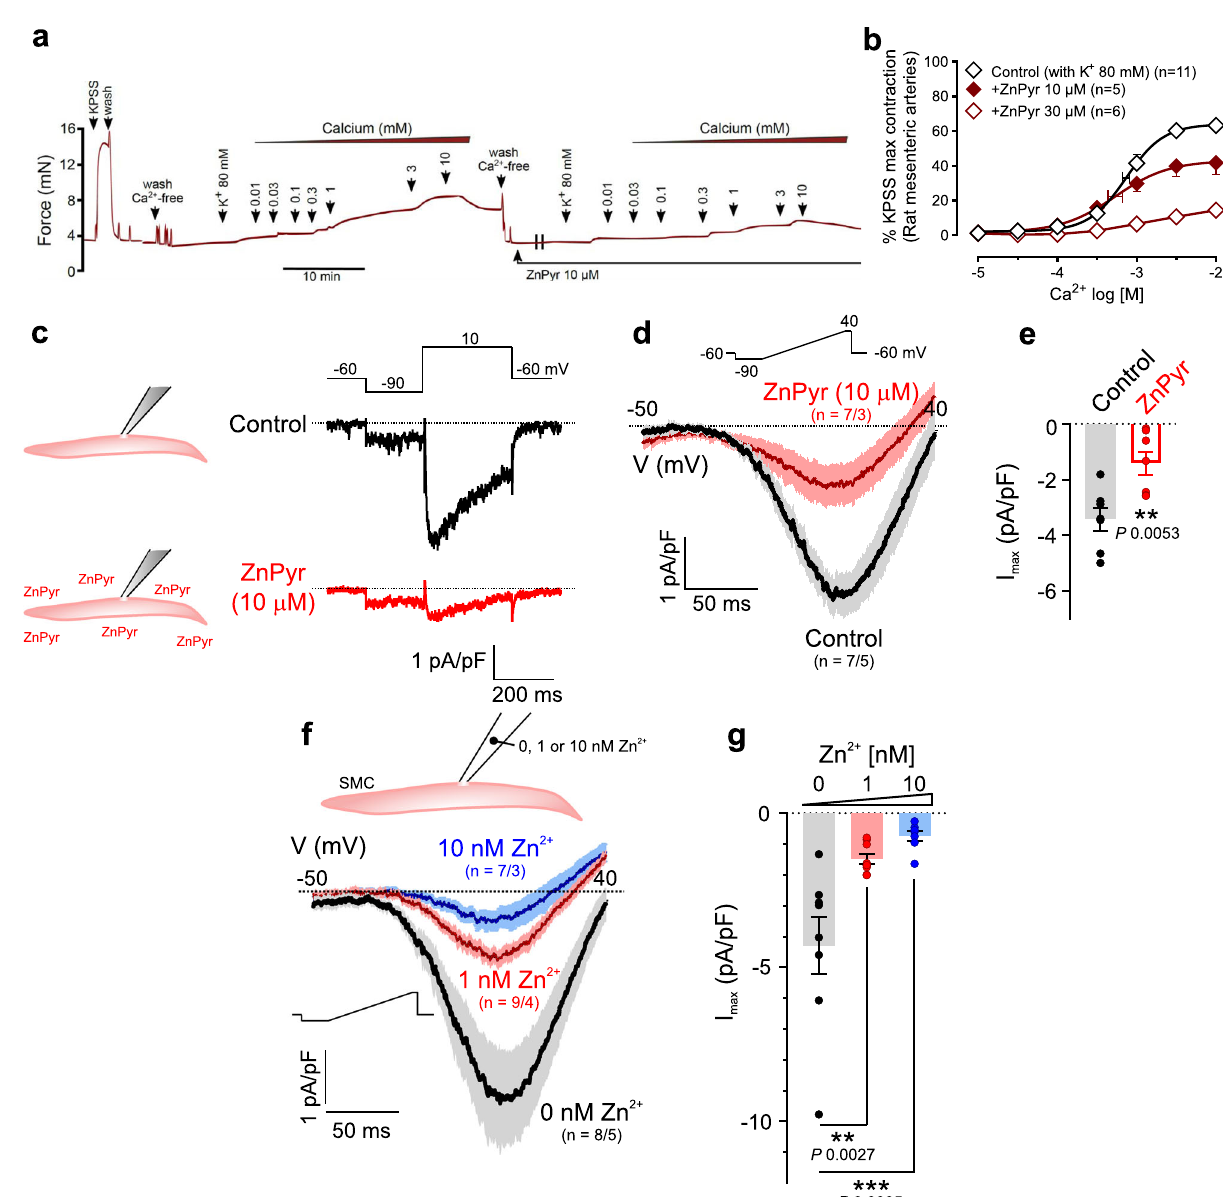
Fig. 6 Effects of zinc on voltage-gated calcium channel (VGCC) current. a , b Effects of zinc pyrithione (ZnPyr) on depolarization-dependent (80 mM KCl), calcium-induced contraction in rat isolated mesenteric arteries. a Representative trace. b Averaged data (%KPSS). n : arteries from separate rats. c – e VGCC current (charge carrier: Ba 2 + ) recorded in mouse freshly isolated mesenteric artery SMCs using the conventional whole-cell con fi guration with/ without zinc pyrithione (10 μ M; ZnPyr). c Representative traces obtained using a test step (10 mV, inset) with/without ZnPyr. d , e Averaged traces of inward currents evoked by a voltage ramp protocol (upper inset, d ) and the maximum current density obtained in these experiments ( I max , e )